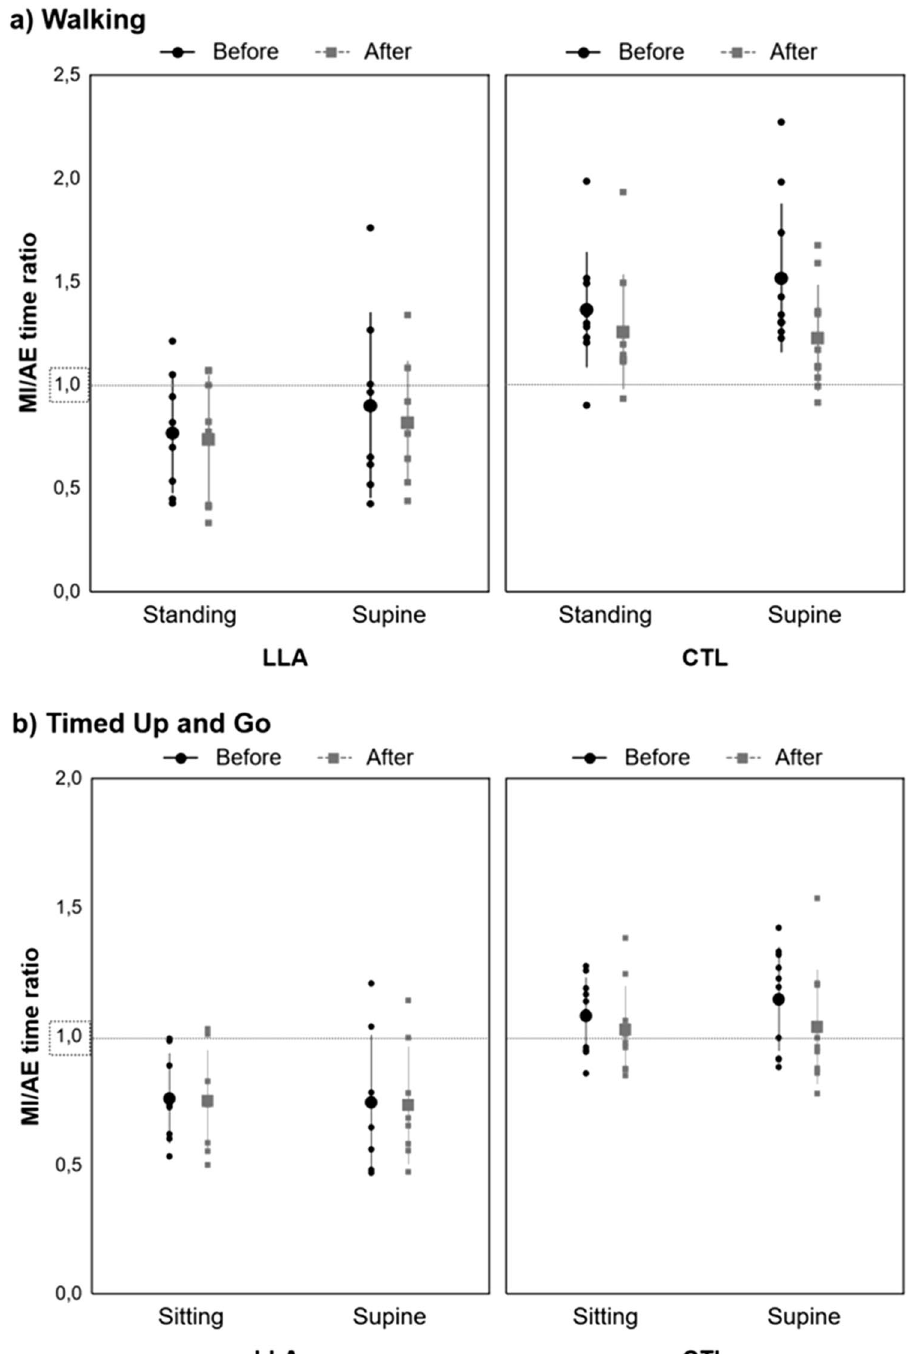
Figure 2. Mean (± SD) MI/AE time ratios in the LLA (n = 8) and CTL (n = 10) groups for ( a ) the walking task, in the standing and supine positions, before and after AE, and ( b ) the TUG task, in the sitting and supine positions, before and after AE. Time ratios under 1 (dot lines) indicate that MI times were shorter than AE times, and conversely for MI/AE time ratios above 1. Small dots and squares represent individual data, large points and squares, mean data, and bars, SD. In the walking task, there was a significant Group effect ( p < .001) with lower ratios in the LLA group compared to the CTL group, a significant Position effect ( p = .030) with lower ratios in the standing-congruent position than in the supine-incongruent position. There was also a significant Order effect ( p = .003) with lower ratios after AE than before AE. In the TUG task, there was a significant Group effect ( p = .003) with lower ratios in the LLA group compared to the CTL group. In both tasks, note that the LLA group underestimated AE times during MI while the CTL group overestimated